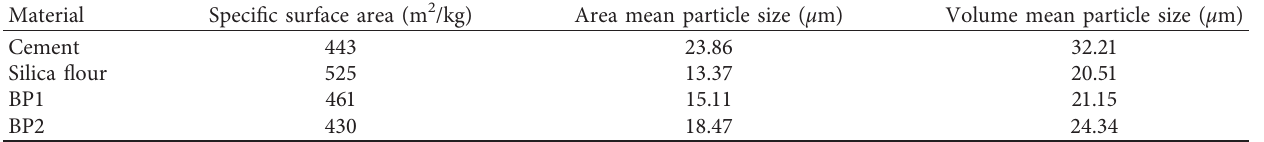
Table 3: Particle characteristics of different powder materials.